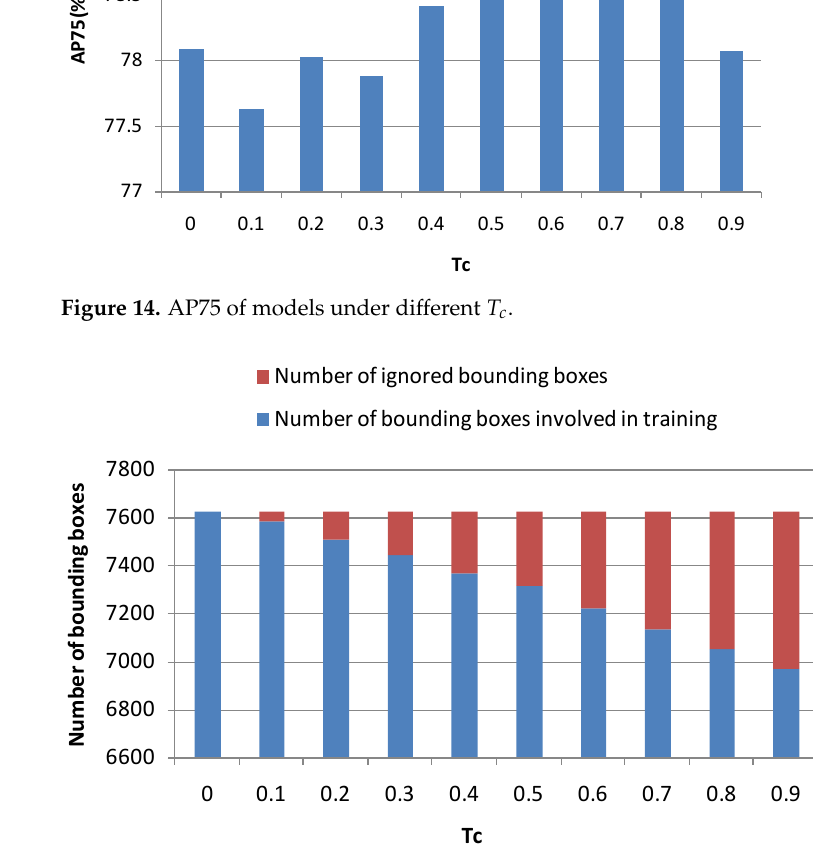
Figure 15. The number of bounding boxes involved in loss calculation and the number of bounding boxes of targets not involved in loss calculation (suppressed by the mask) in a training epoch.